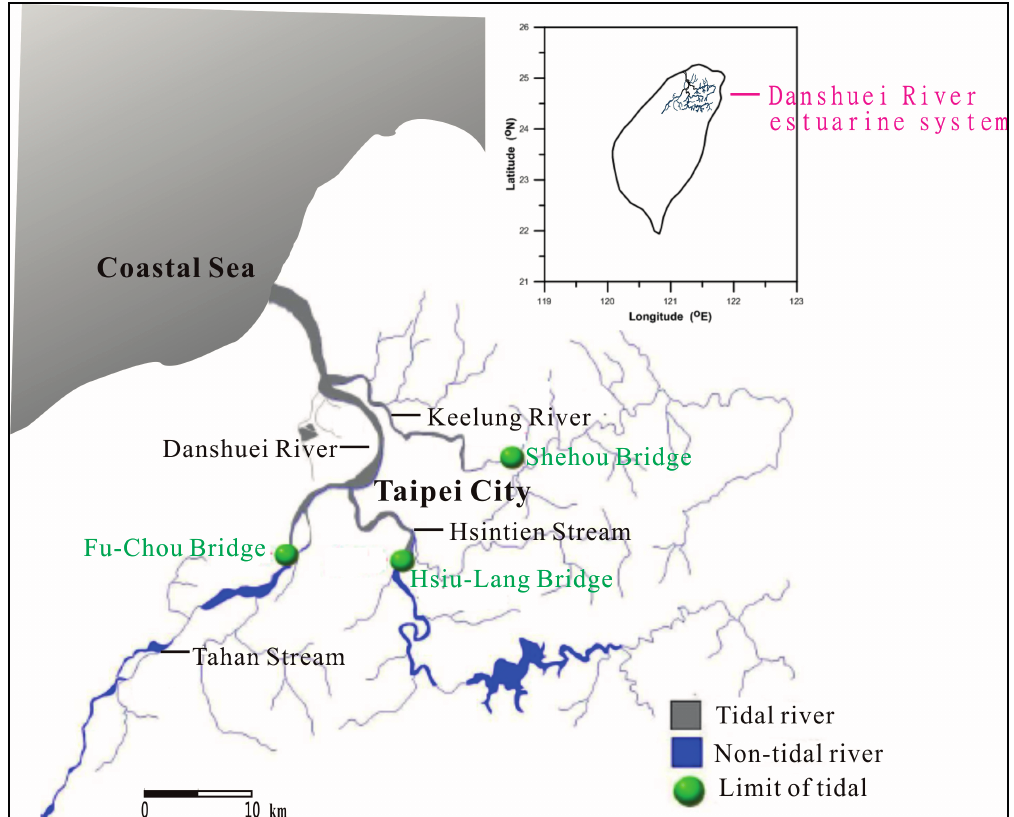
Figure 1. Danshuei River estuarine system and